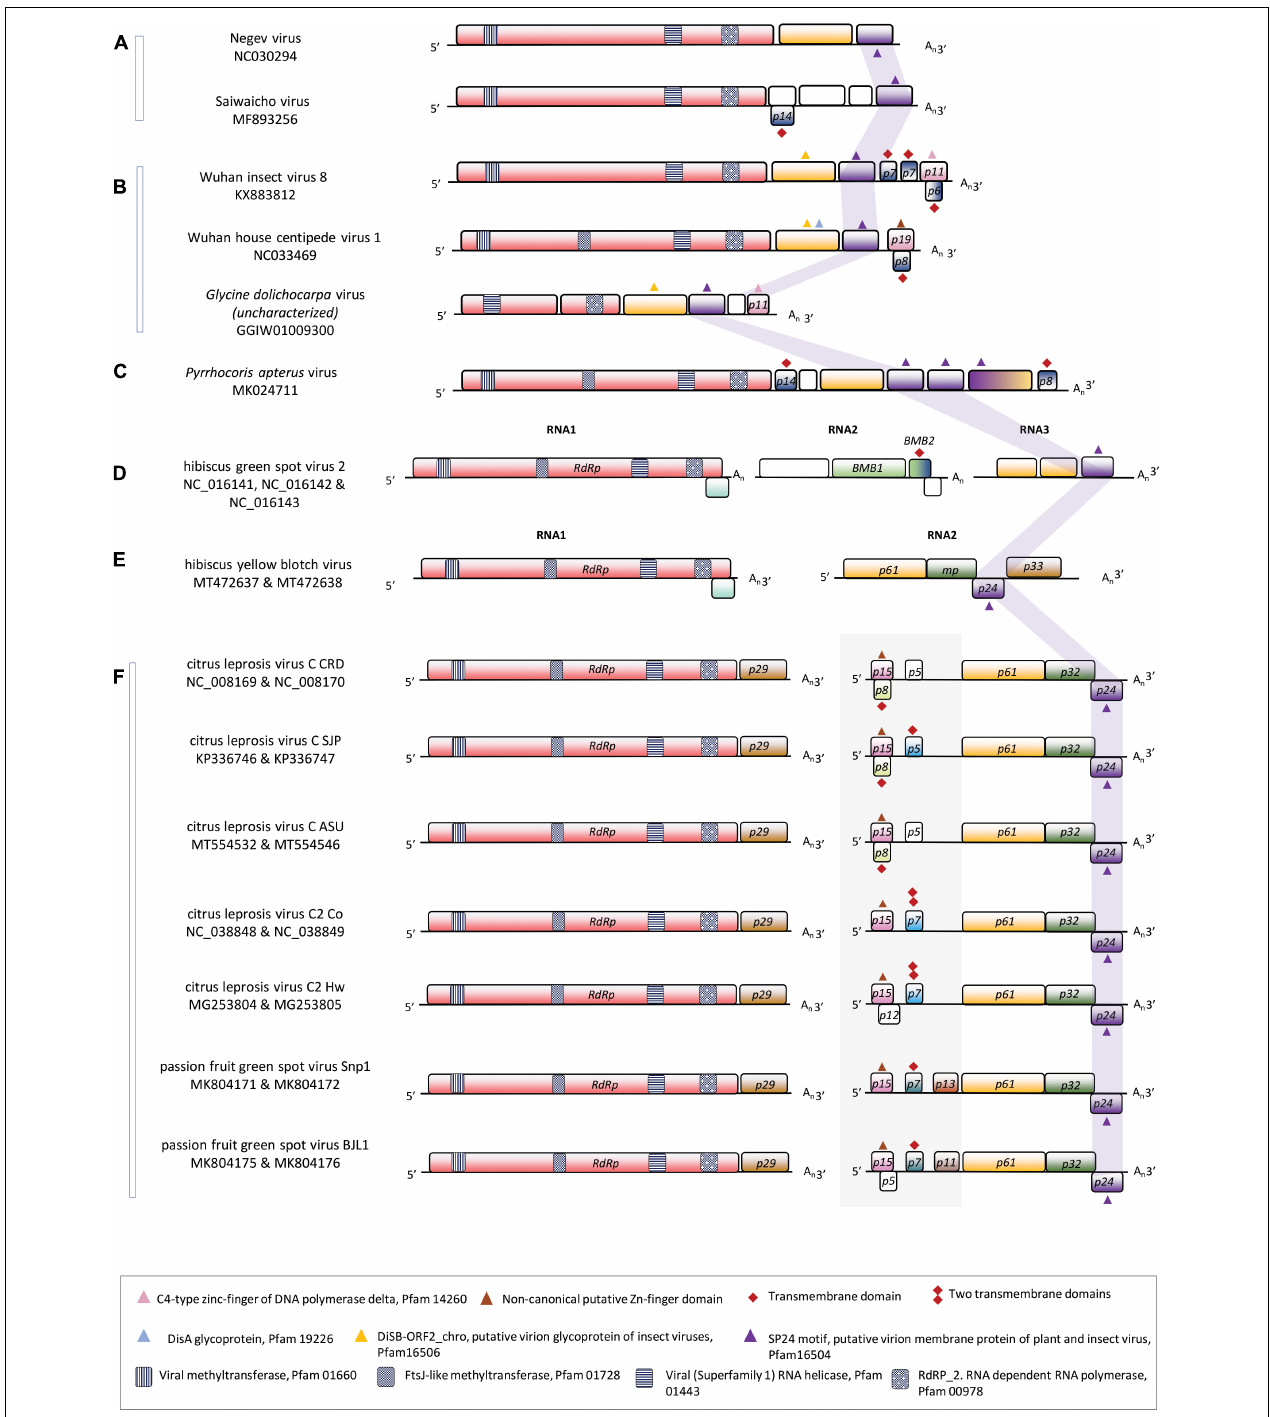
FIGURE 1 | Linear genomic maps of some members of the family Kitaviridae and some of their closest phylogenetically arthropod-infecting viruses. (A) Two members of the group Negevirus, (B) two members of the group centivirus, (C) unclassified kita/nege-like virus, (D) the sole member of the genus Higrevirus , (E) a cile-like virus, and (F) members of the genus Cilevirus . Open reading frames are represented by boxes and the fill colors indicate a conserved functional or structural relationship between them. White boxes indicate unknown features. The solid gray background box in (F) highlights the 5 (cid:48) -end of the RNA2 genomic segment of cileviruses. The purple ribbon points out the position of the ORFs containing the SP-24 motif (structural protein of 24 kDa, Pfam code PF16504). Small geometric symbols show the presence of relevant sequences as described in the legend box.